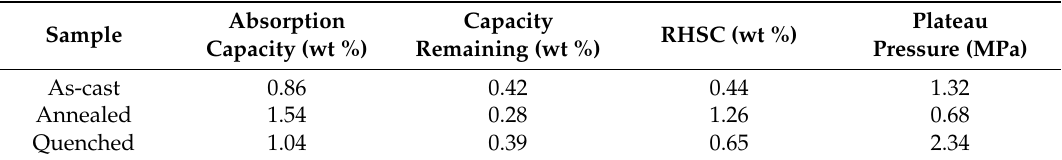
Table 3. Effect of heat treatment on H storage properties of Ti 34 V 40 Cr 24 Fe 2 alloy.